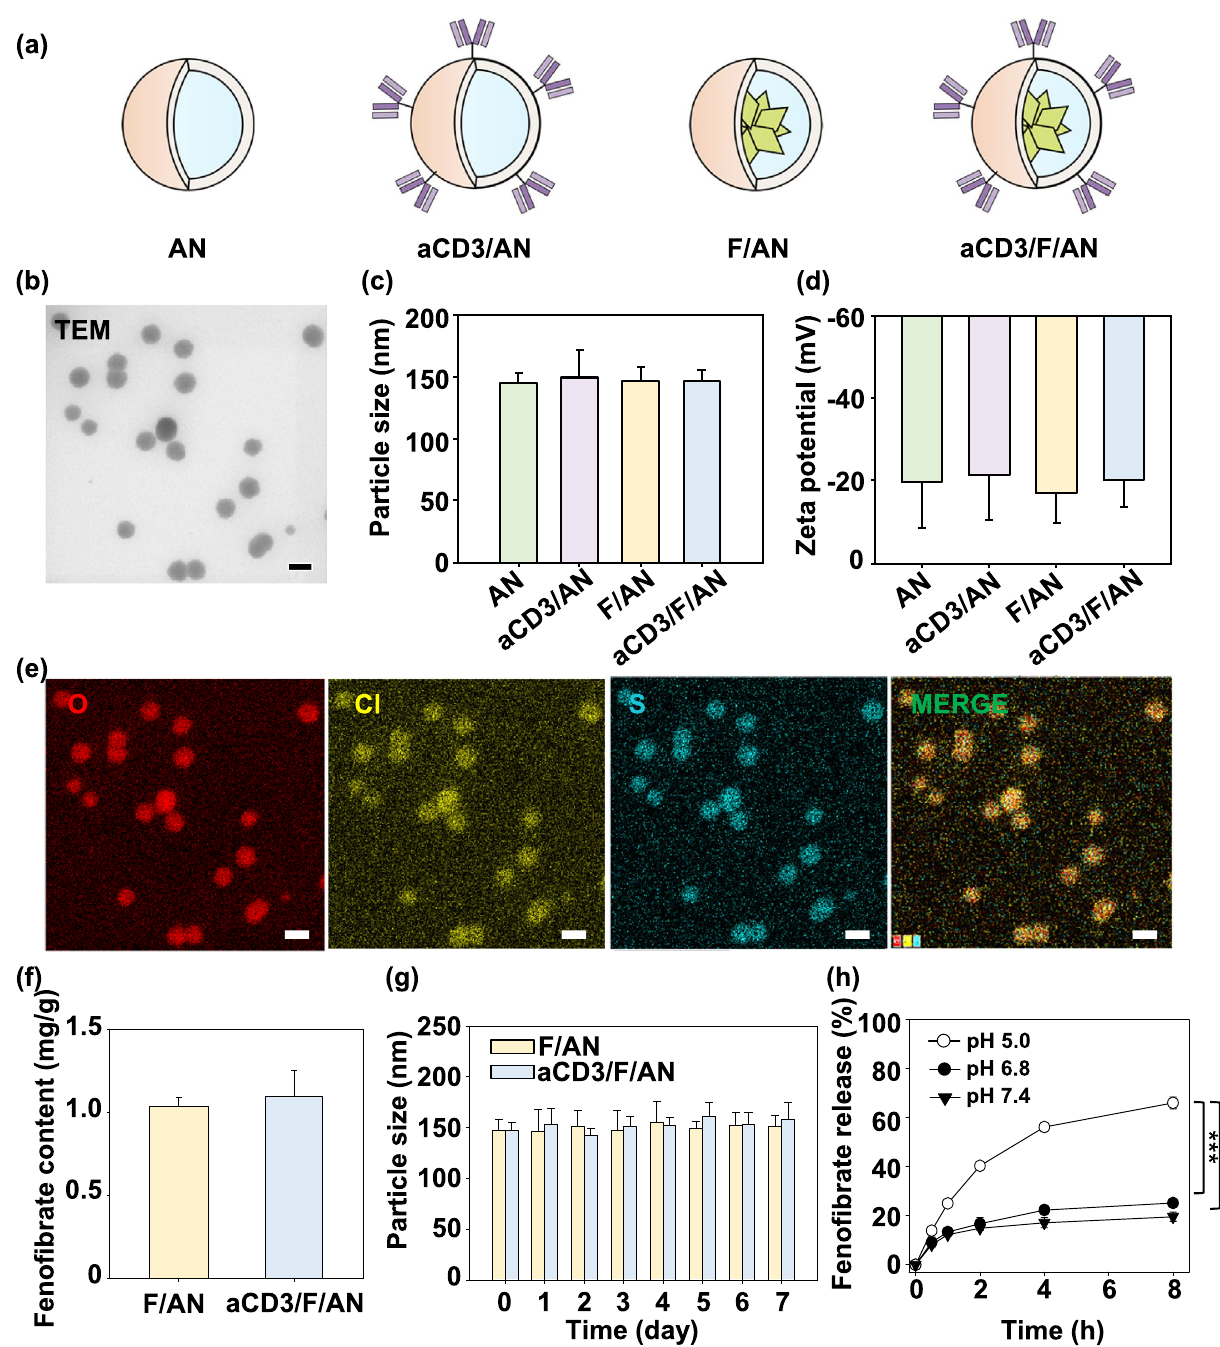
Fig. 2 Characterization of nanoparticles. a Schematic illustration of ANs, aCD3/ANs, F/ANs and aCD3/F/ANs. b Morphology of aCD3/F/ANs, observed by TEM. Scale bar: 200 nm. c Mean particle size of different nanoparticles, determined using DLS. d Zeta potential of nanoparticles, measured by laser Doppler microelectrophoresis. e Characterization of aCD3/F/ANs with respect to the elements oxygen, chloride and sulfur, conducted by STEM‑EDS. Scale bar: 200 nm. f Amount of fenofibrate encapsulated in nanoparticles, quantified by HPLC. g Particle sizes of F/ ANs and aCD3/F/ANs in PBS, monitored for 7 days. h Release of fenofibrate from aCD3/F/ANs, quantified by HPLC under different pH condi‑ tions (***P <